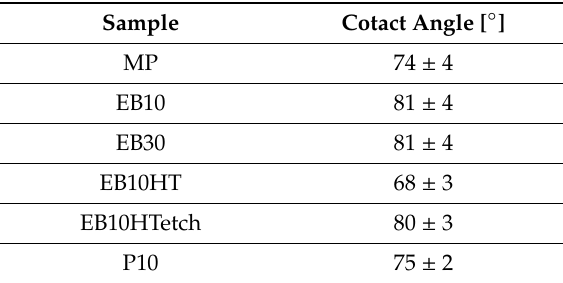
Table 3. Contact angle